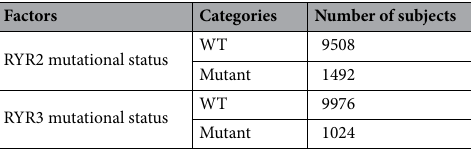
Table 1. Demographic and clinicopathological information for subjects involved in this study. *1 = Lifelong Non-smoker (less than 100 cigarettes smoked in Lifetime), 2 = Current smoker (includes daily smokers and non-daily smokers or occasional smokers), 3 = Current reformed smoker for > 15 years (greater than 15 years), 4 = Current reformed smoker for ≤ 15 years (less than or equal to 15 years), 5 = Current reformed smoker, duration not